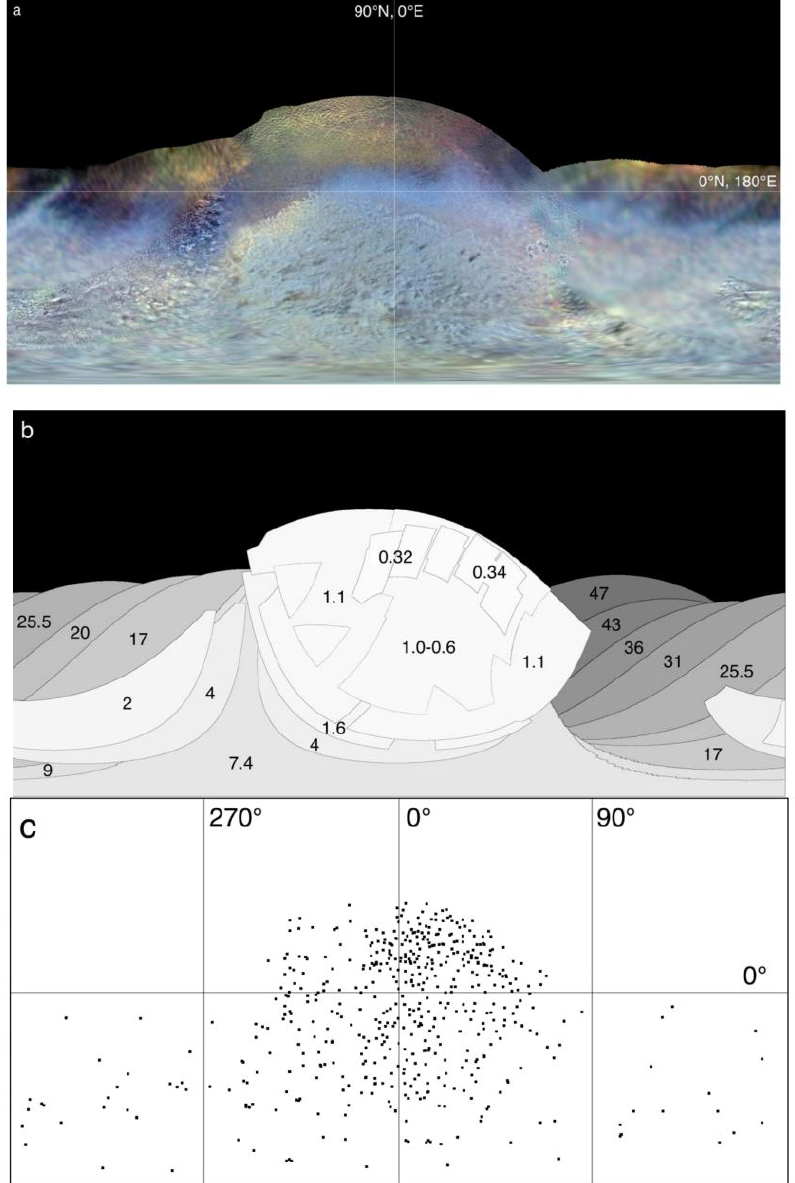
Figure 1. ( a ) Global color map mosaic of Triton. Color-composite uses orange, green, and UV filters for red, green, and blue colors. Simple cylindrical projection at 0.35 km/pixel from − 180 ◦ to 180 ◦ E longitude (same map projection used in all similar maps unless noted). ( b ) Resolution map of Triton showing footprints and effective image resolutions in km/pixel for the observations used in construction of the global map in Figure 1a. ( c ) Map of match point distribution used for updated global control network for Triton and global mosaic shown in Figure